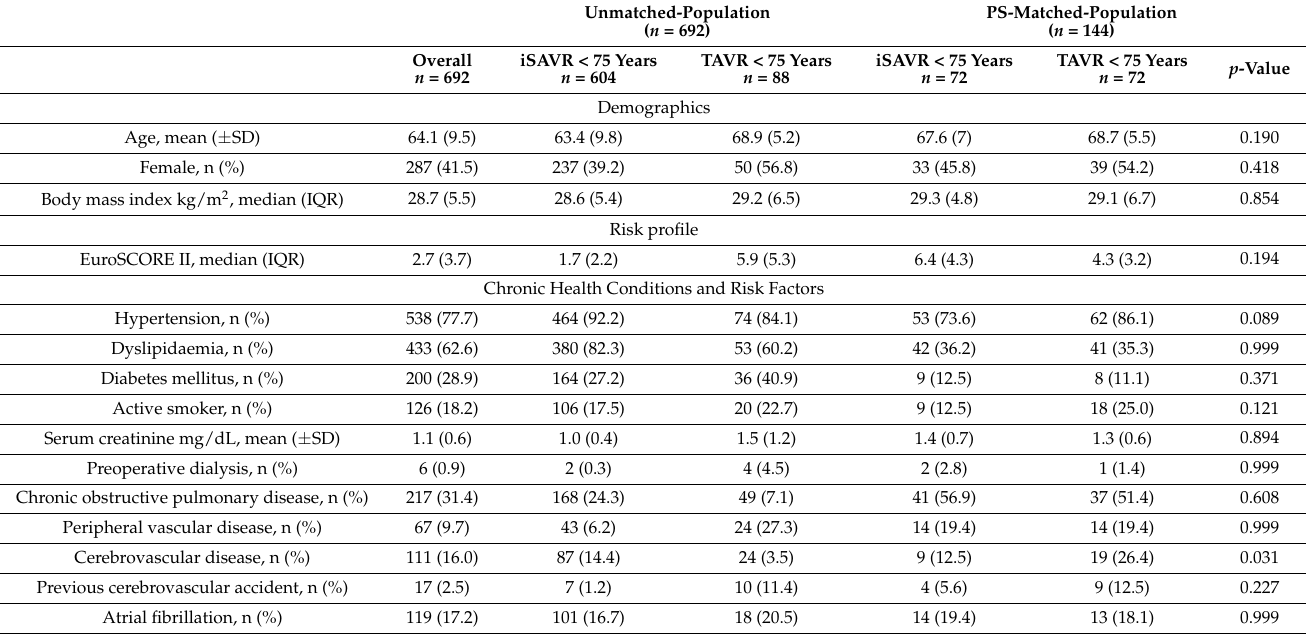
Table 2. Baseline clinical characteristics of the unmatched and matched